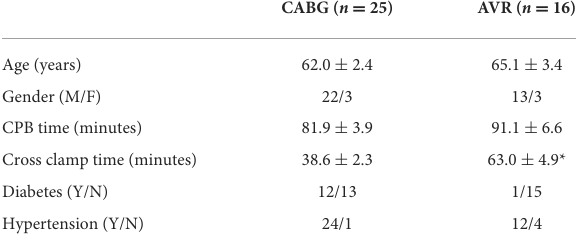
TABLE 1 Patient